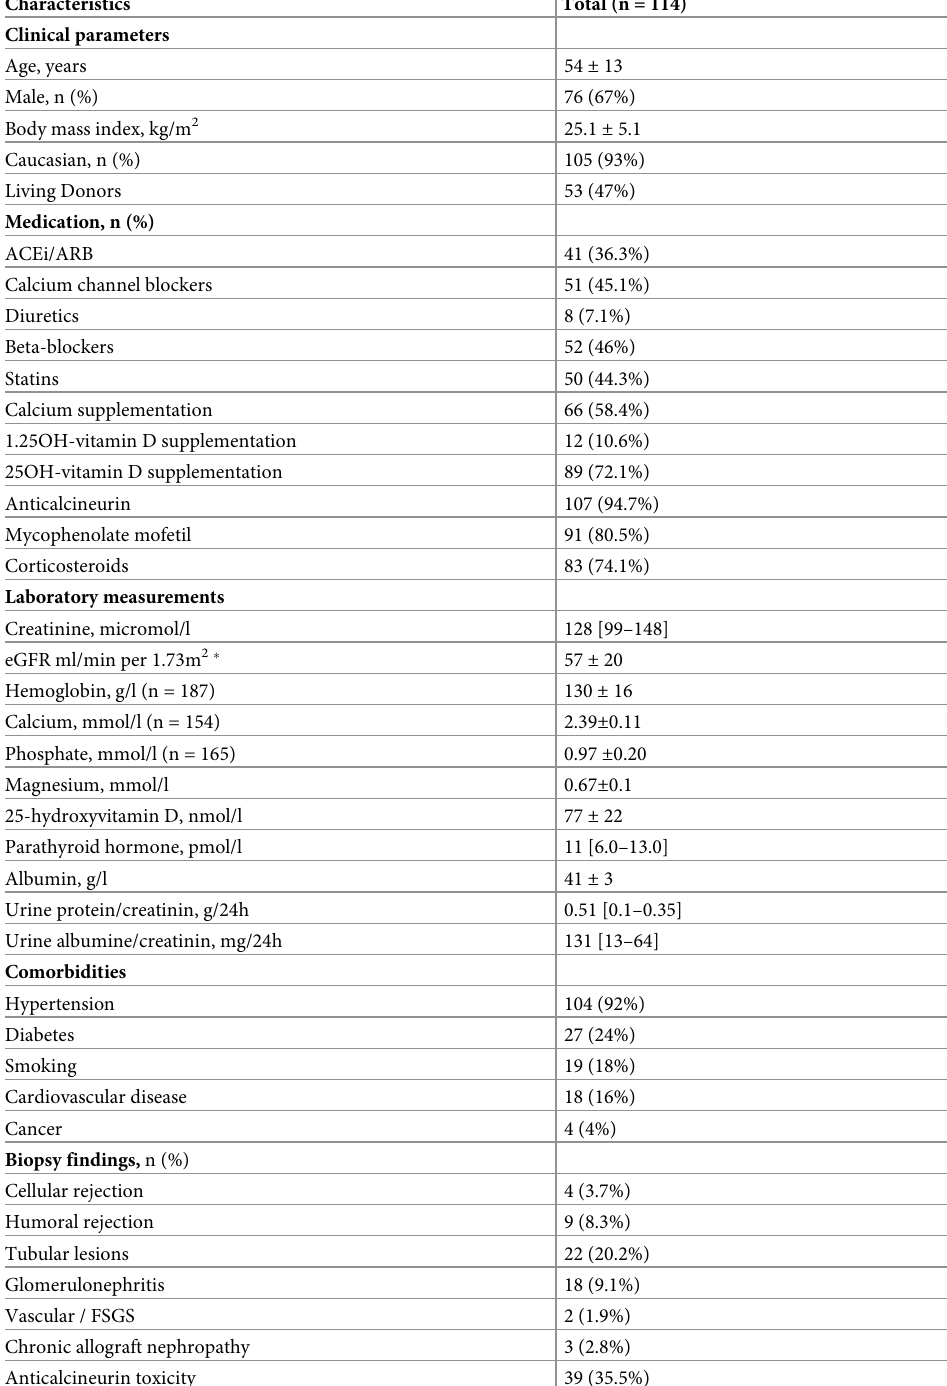
Table 1. Baseline characteristics of the study population (n = 114): Clinical parameters, medication, laboratory measurements, biopsy diagnosis and chronic histological lesions at the time of